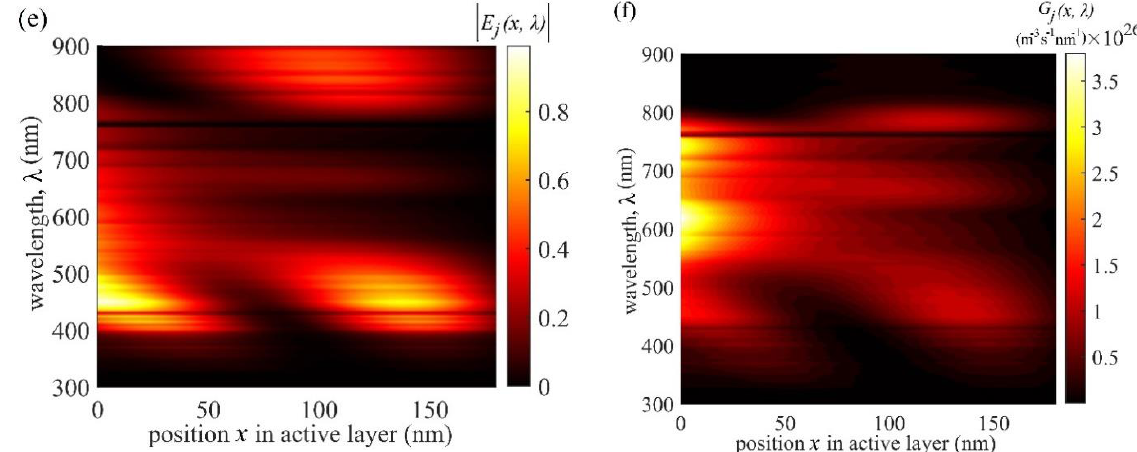
Figure 5. Left column presents the contour plots of |𝐸 𝑗 (𝑥, 𝜆)| from Equation (5) in the active layer of OSC1 for three different thicknesses 𝐿 𝑗 , ( a ) 35 nm, ( c ) 95 nm, and ( e ) 180 nm. The right column presents the corresponding 𝐺̇ 𝑗 (𝑥, 𝜆) contour plots from Equation (3) for the three thicknesses: ( b ) 35 nm, ( d ) 95 nm, and ( f ) 180 nm. The brighter spots on the left figures represent regions of the constructive interference of electric field of electromagnetic (EM) waves within the active layer and the darker spots represent regions of destructive interference. Likewise, the brighter spots on the right figures represent the positions of higher 𝐺̇ 𝑗 (𝑥, 𝜆) and darker spots that of lower 𝐺̇ 𝑗 (𝑥,𝜆). As a BHJ OSC is a multilayer stack, these brighter and darker regions of |𝐸 𝑗 (𝑥, 𝜆)| in